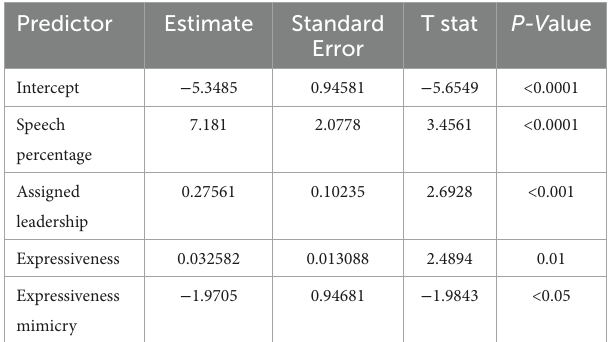
TABLE 1 Leadership selection model.